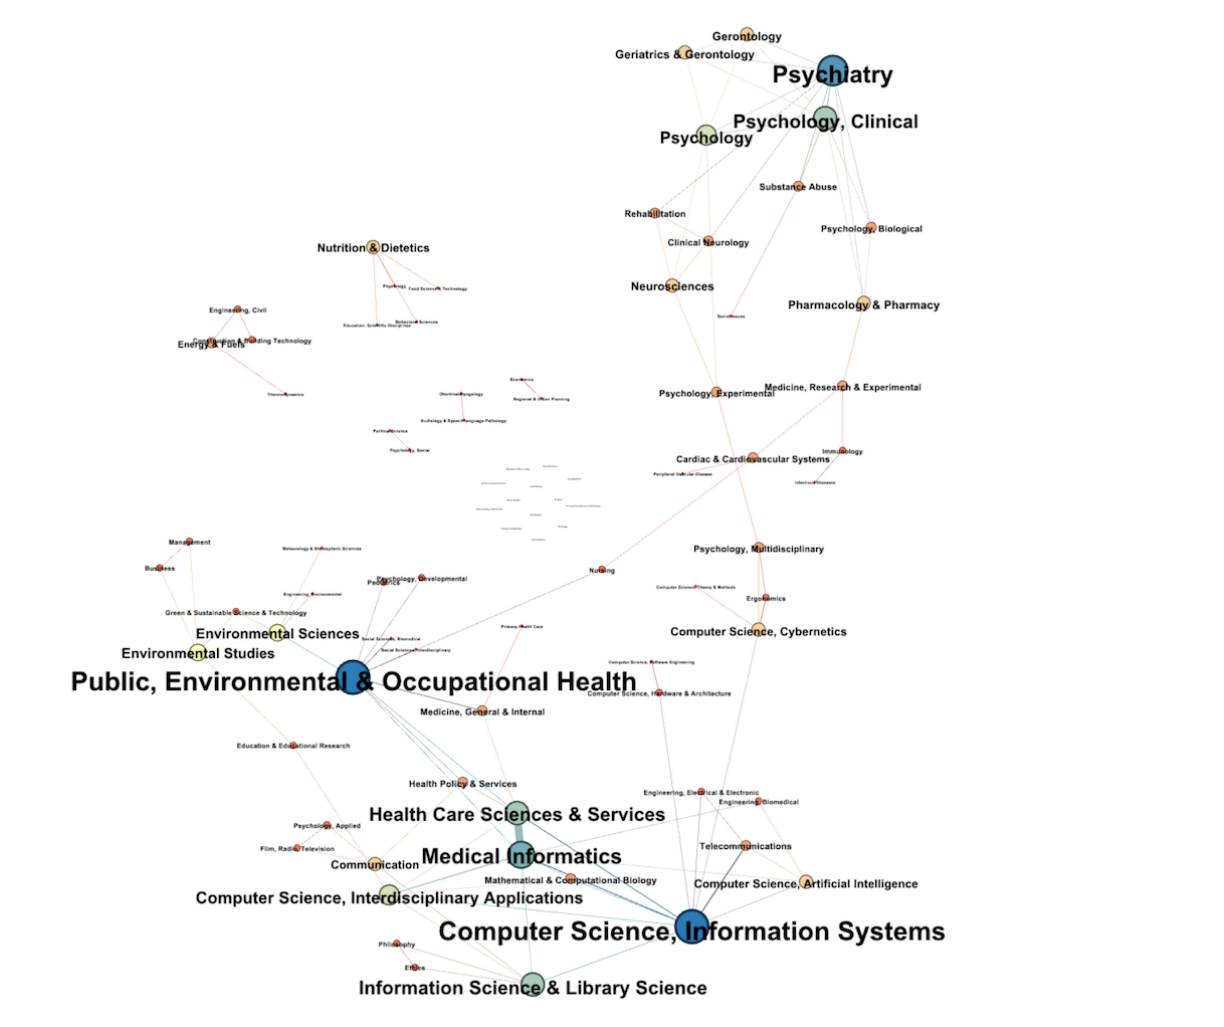
Figure 3. Disciplines involved in persuasive technology and health behavior change.